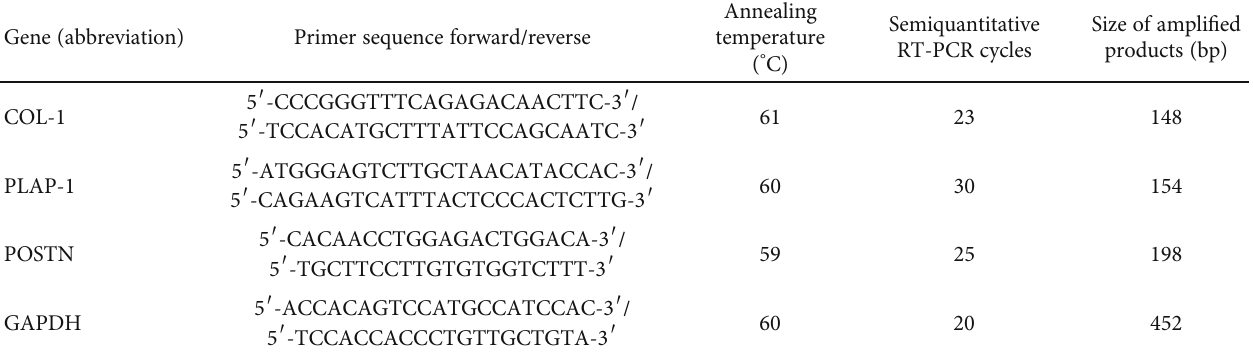
Table 1: Primer sequences, annealing temperatures, cycle numbers, and product sizes for semiquantitative RT-PCR. Gene